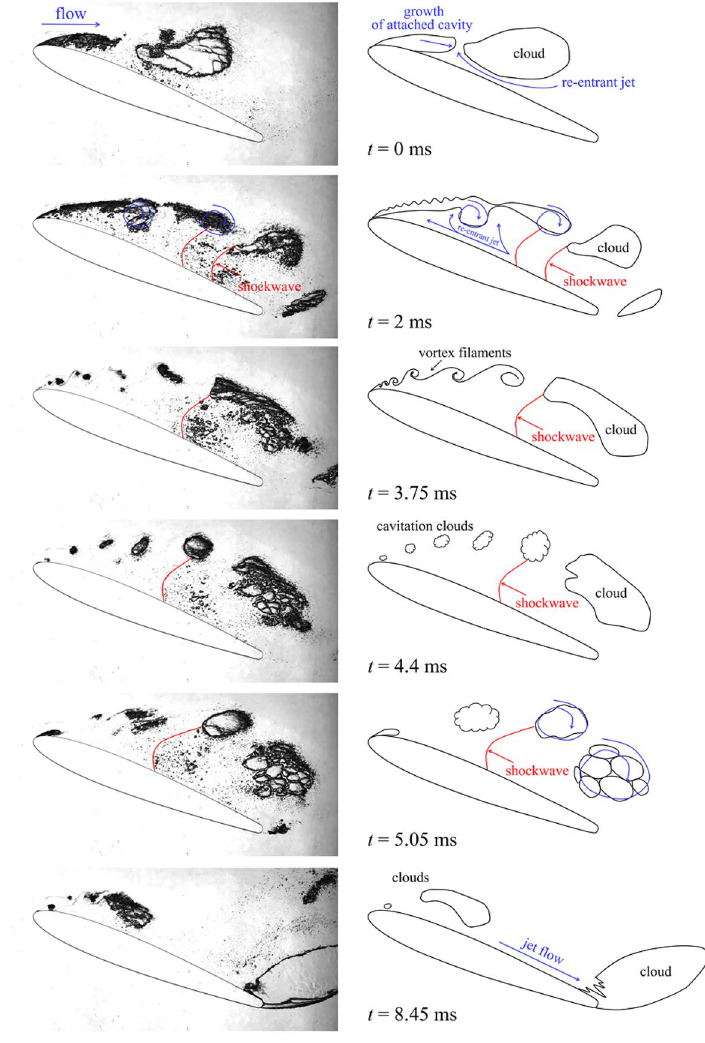
Figure 2. Cavitation cycle for the NACA0012 hydrofoil with AR = 0.02. σ = 2.41 (see Supplementary